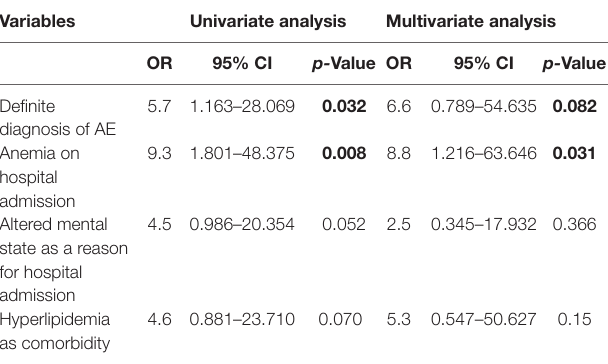
TaBle 3 | Uni- and multivariate analysis of risk factors for intensive care unit admission in patients with autoimmune